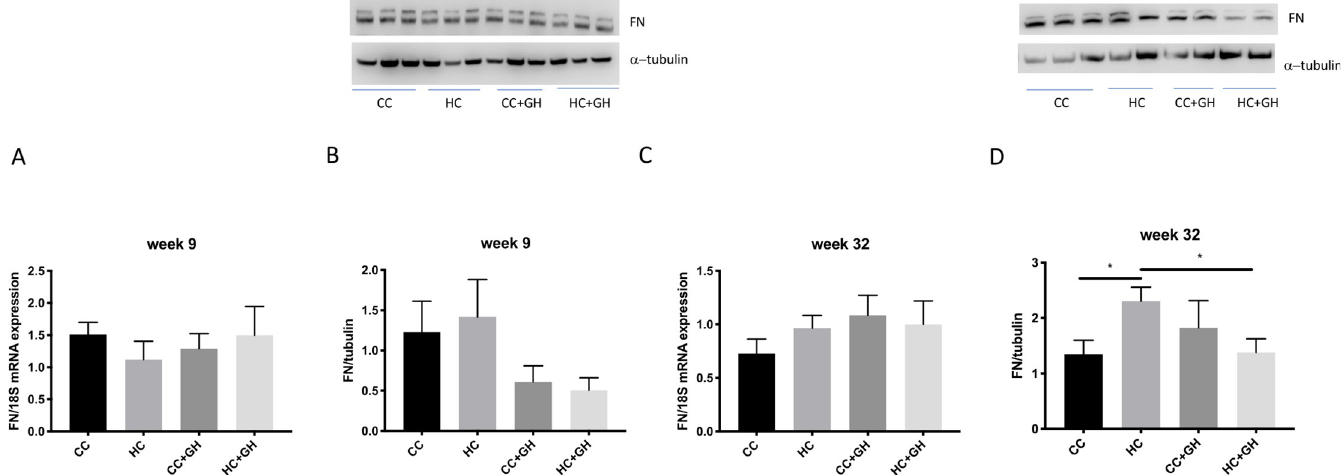
Fig 10. Renal fibrotic changes as measured by fibronectin (FN). (A) Week 9 offspring mRNA expression of FN, (B) week 9 offspring western blotting for FN, (C) week 32 offspring mRNA expression of FN, (D) week 32 offspring western blotting for FN. Results expressed as mean ± SEM, n = 6. � p < 0.05.